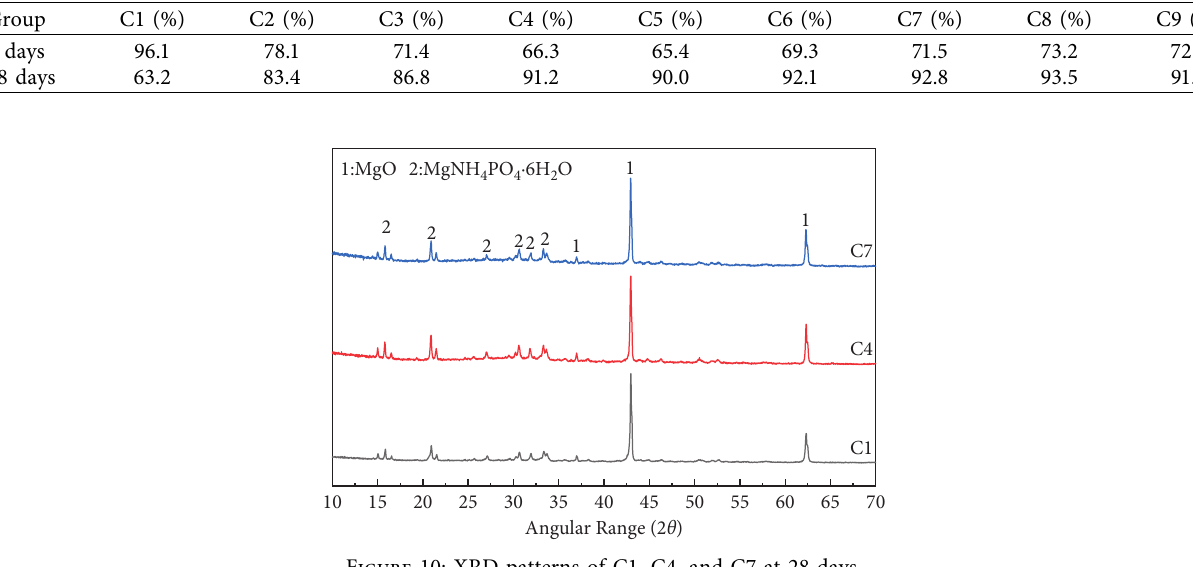
Table 4: The water resistance of the hardened sample.